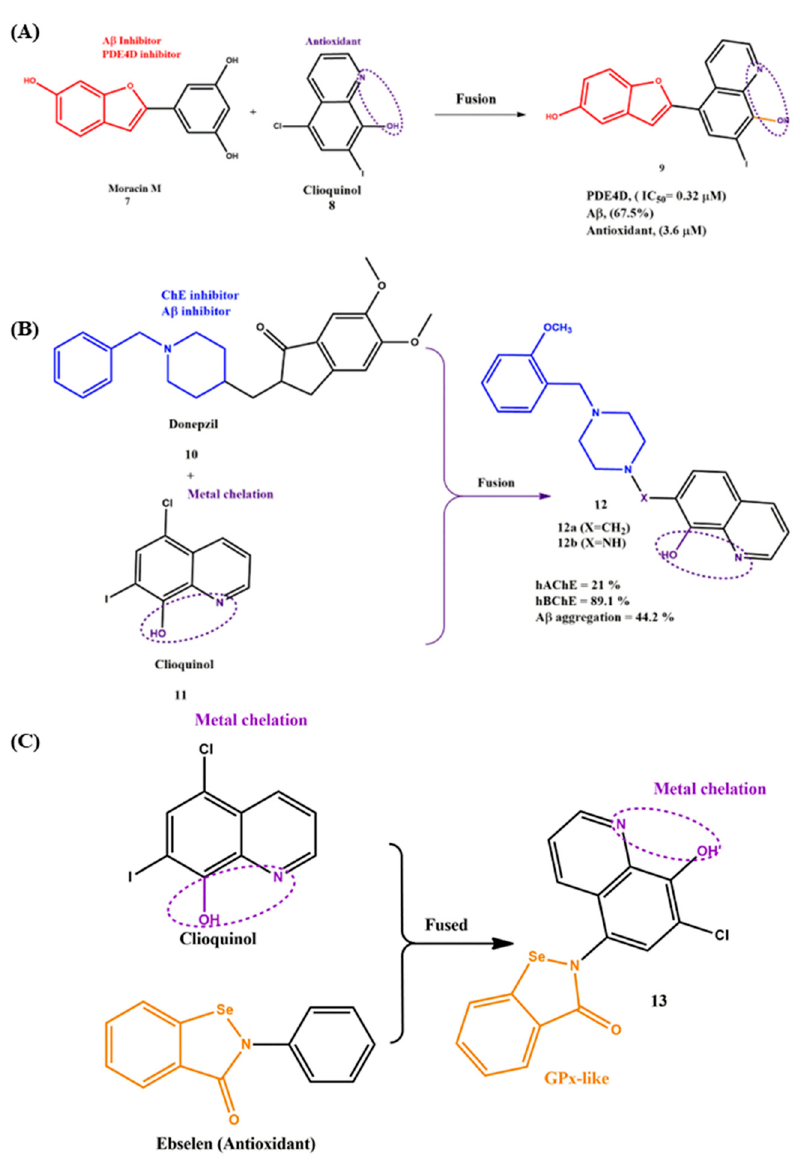
Figure 5. ( A − C ) Representative structure of fused pharmacophores. Figure 5. ( A – C ) Representative structure of fused